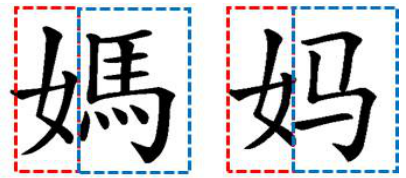
Figure 5. The radials are separated to the left and right of the character.